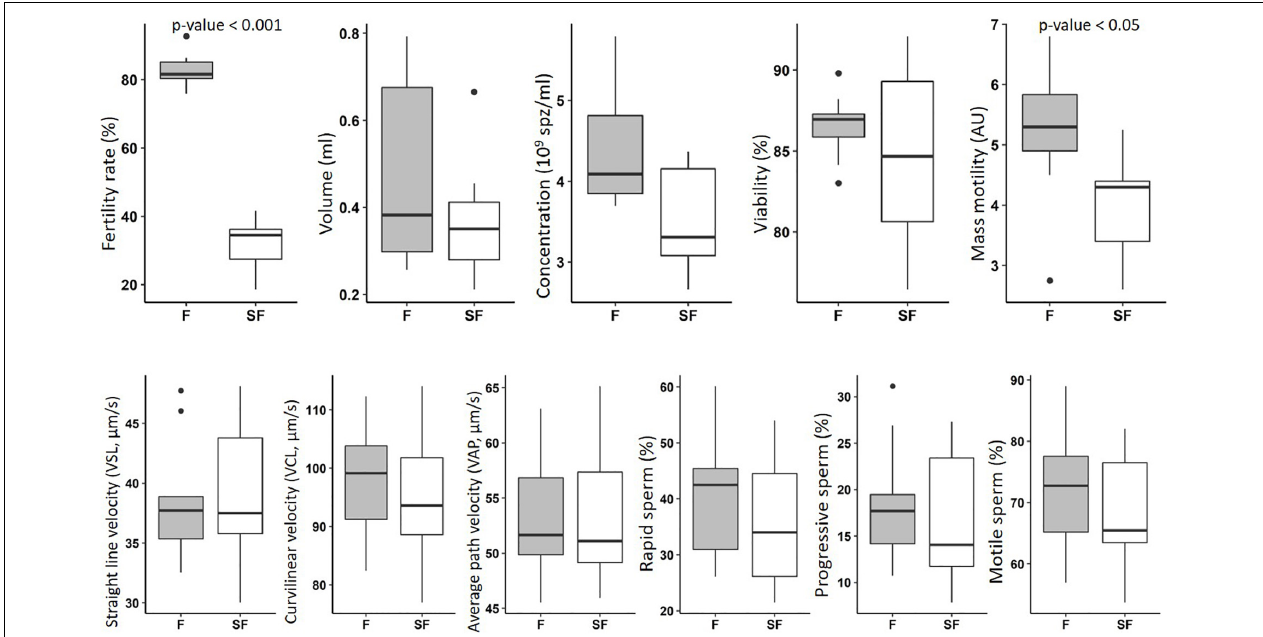
FIGURE 1 | In vitro characterization of semen from fertile (F) and subfertile (SF) meat-line chickens. Semen samples (9 roosters per fertility status) were subjected to in vitro evaluation including the determination of volume, concentration, viability, and several motility parameters. F animals in gray; SF animals in white. Data were analyzed with Mann–Whitney test and statistical difference was defined with p ≤ 0.05.